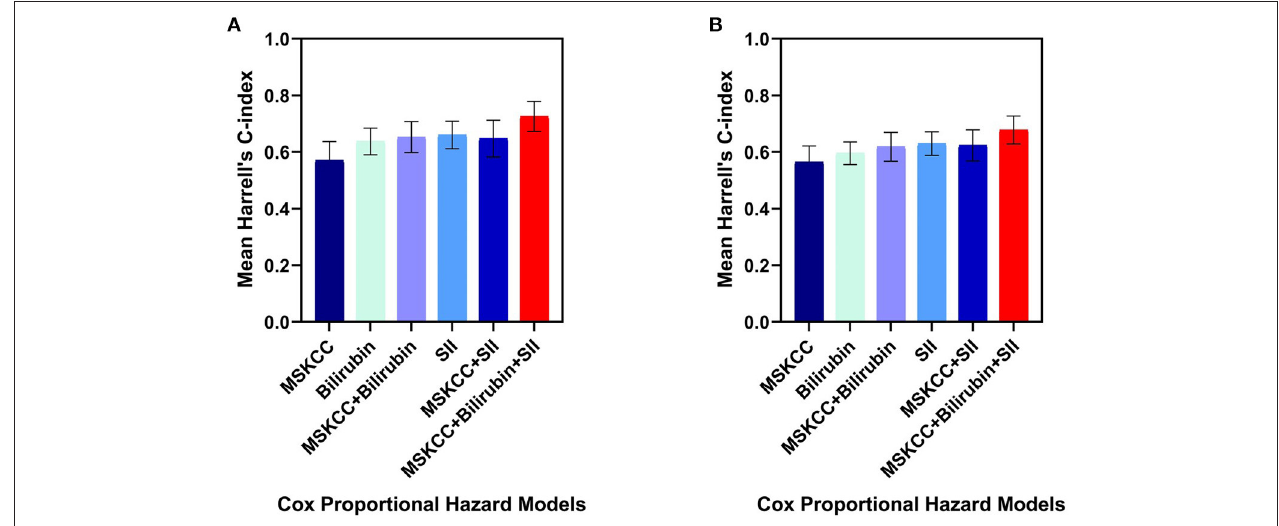
FIGURE 2 | Harrell’s C -index of five different Cox proportional hazard models on overall survival (A) and progression-free survival (B) : MSKCC score alone, bilirubin alone, SII alone, bilirubin plus MSKCC score, SII plus MSKCC score, bilirubin and SII plus MSKCC score separately. The error bars represent the standarad deviation of the Harrell’s C -index. C-index, concordance index; SII, systemic immune-inflammation index; MSKCC, Memorial Sloan Kettering Cancer